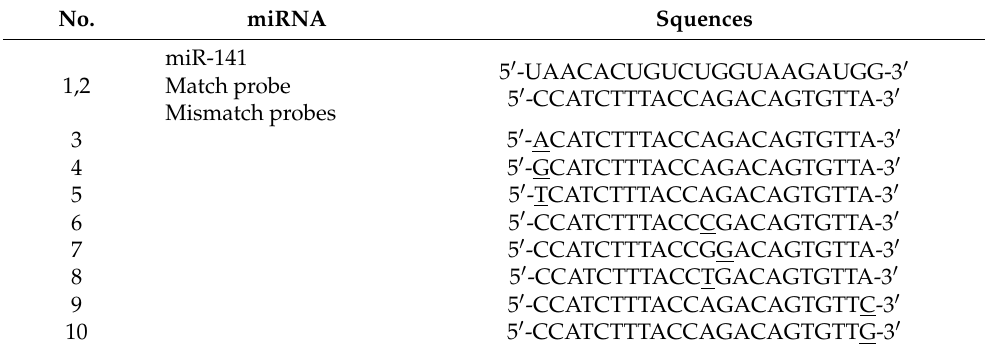
Table 1. Matching and mismatching sequences for prostate cancer miR-141.